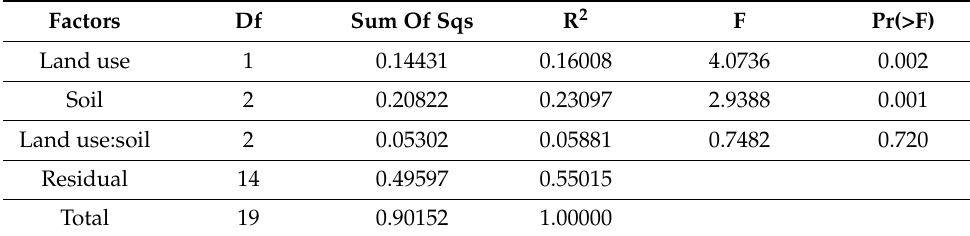
Table 3. Permutational multivariate analysis of influence of agricultural usage (Land use) and Chernozem subtype (Soil) on the structure of soil communities.